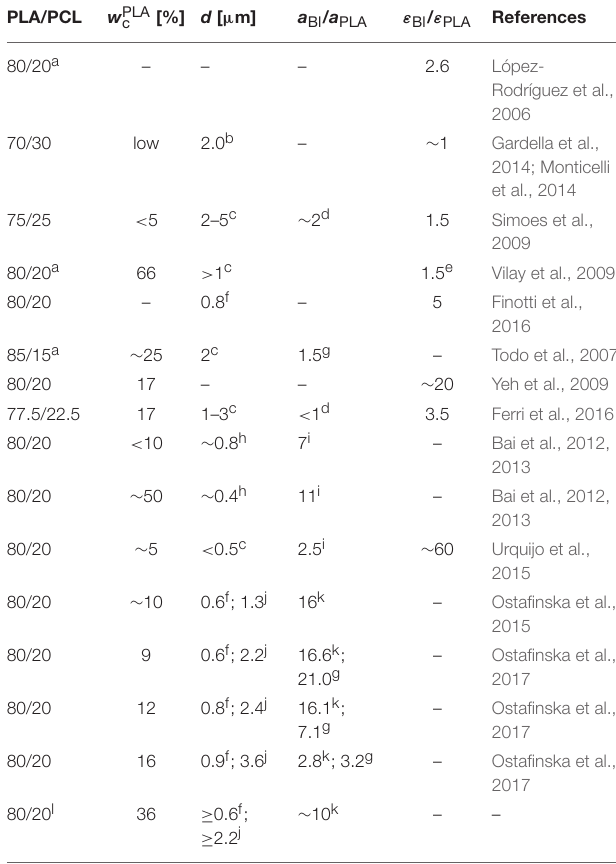
a PLLA matrix; b Maximum of graphical diameter distribution; c Estimated from the figure; d Unnotched Charpy impact strength; e Fracture energy from tensile testing; f Number